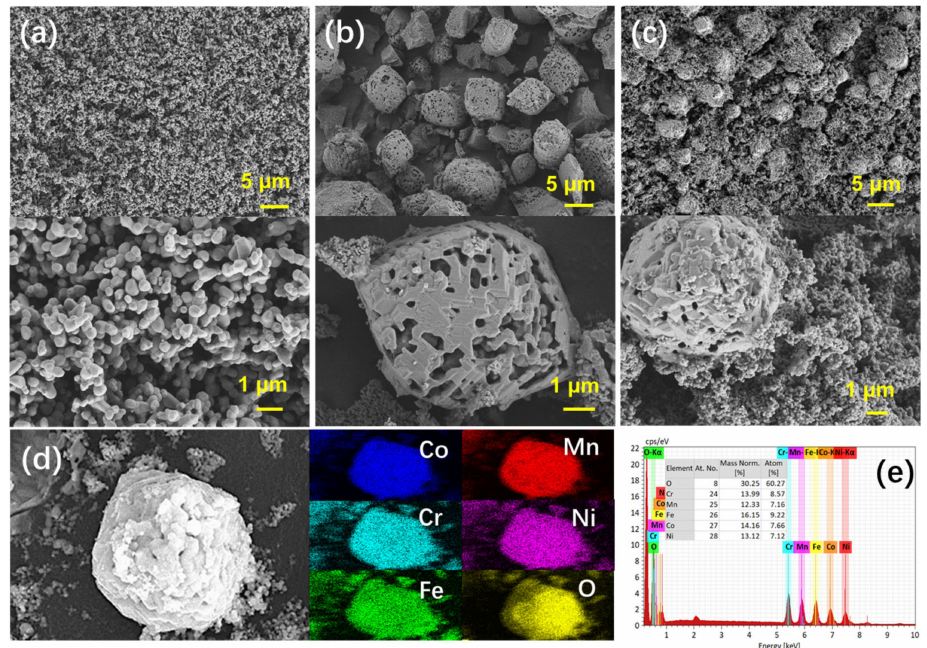
Figure 3. Images of the proposed HEMO materials. FE-SEM micrographs of ( a ) HEMO1, ( b ) HEMO2, ( c ) HEMO3 samples, and ( d ) EDX elemental mapping images of HEMO3 sample, and ( e ) composition of HEMO3